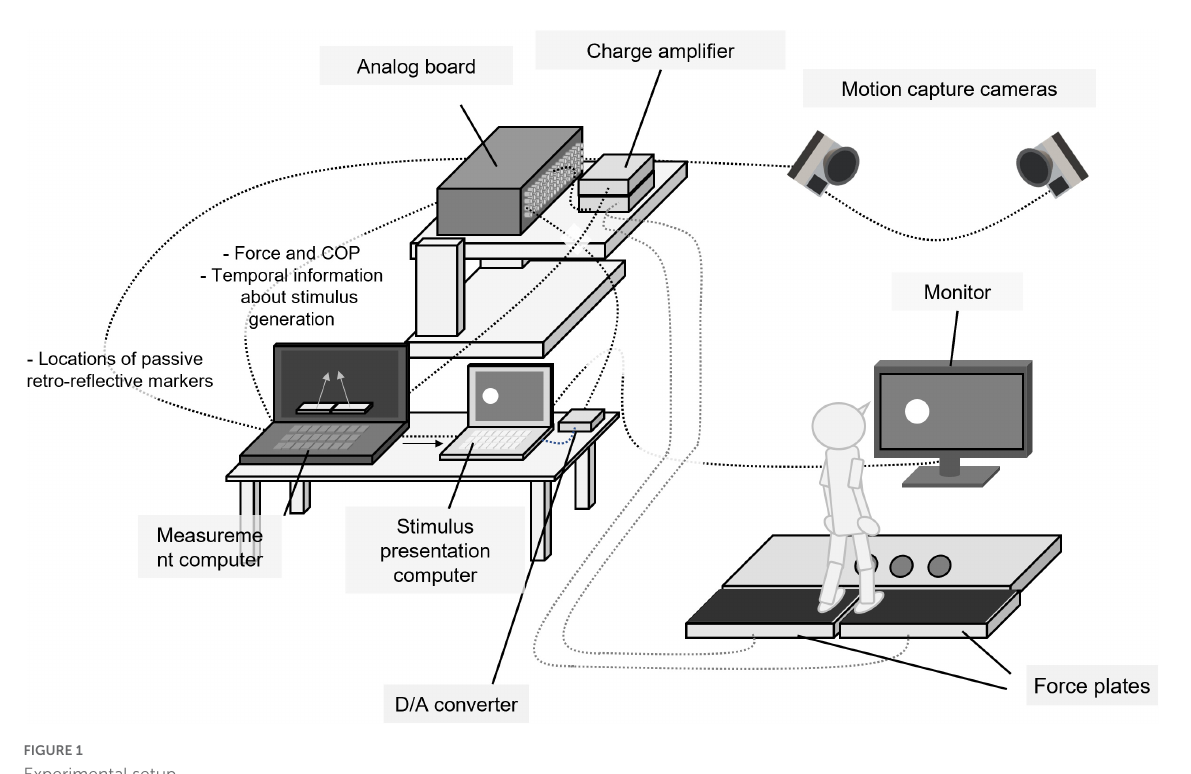
FIGURE1 Experimental